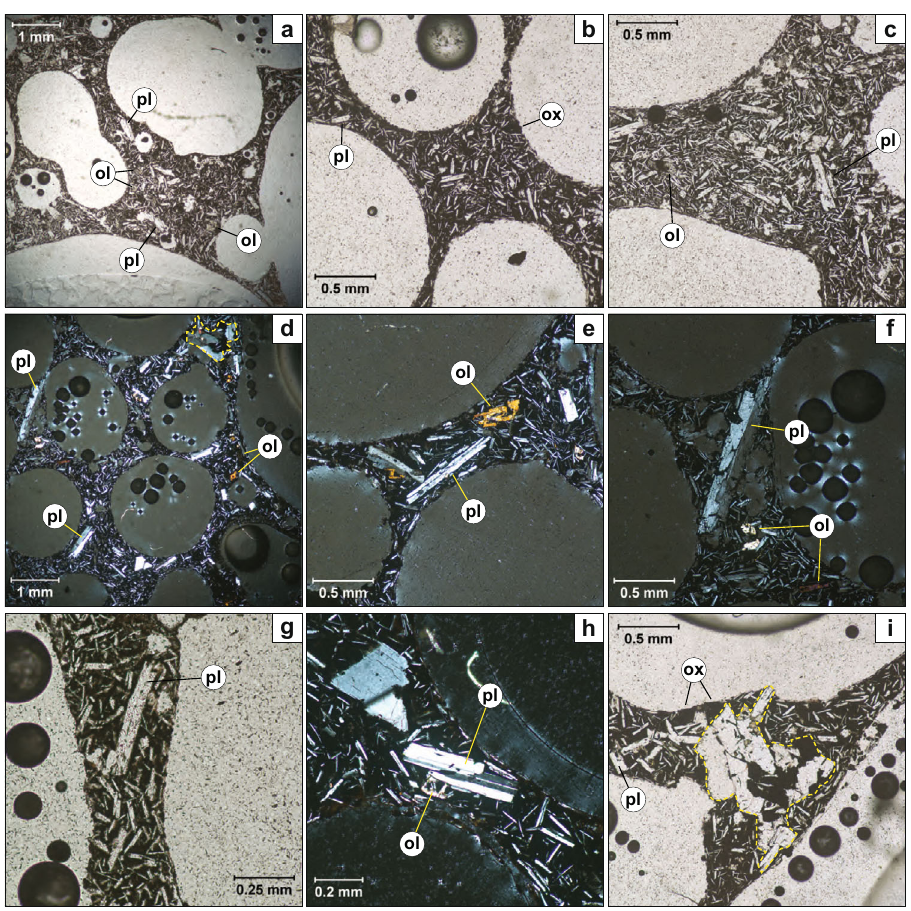
Fig. 4 Microphotographs of an in fl ated pyroclast (Sample: IP_211015_A; see Fig. S2h). a – c PPL, phenocrysts of plagioclase, olivine and oxide in a microcrystalline matrix (plagioclase + olivine + oxide + minor interstitial glass). d , e XPL, same as a - c . f XPL, a 1 mm long plagioclase phenocryst surrounded by three large vesicles and several smaller ones (0.1 – 0.2 mm in diameter). g PPL, close up of a thin boundary between two large vesicles. Note the dense population of plagioclase microlites. h XPL, a plagioclase microphenocryst and microcrystalline matrix between two vesicles. A broken fragment of a plagioclase xenocryst is in the upper left corner of the microphotograph. i A glomerocryst surrounded by three large vesicles. Glomerocrysts of plagioclase + olivine + oxide are outlined in a dashed yellow line in ( d , i ). Phenocryst phases are labelled. Abbreviations: pl: plagioclase; ol: olivine; ox: oxide (previously identi fi ed as titanomagnetite 53